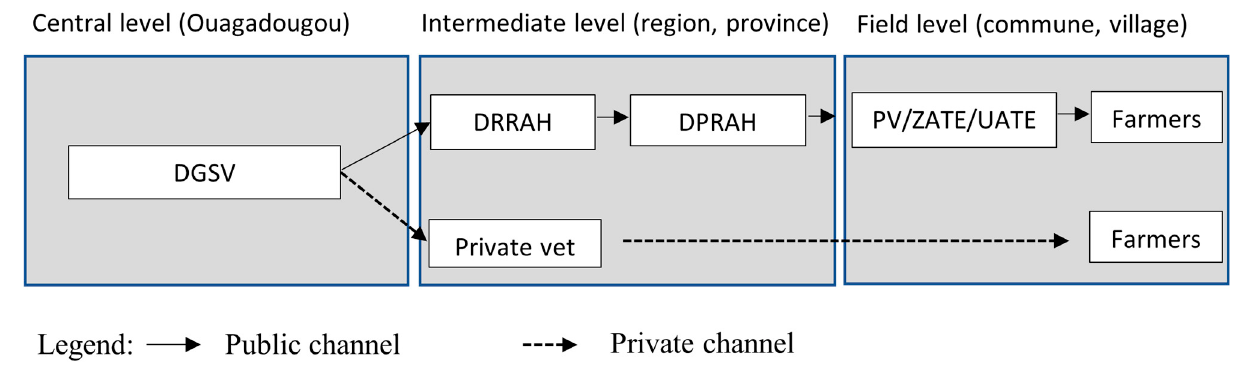
Figure 2. PPR vaccine distribution channels in Burkina Faso.